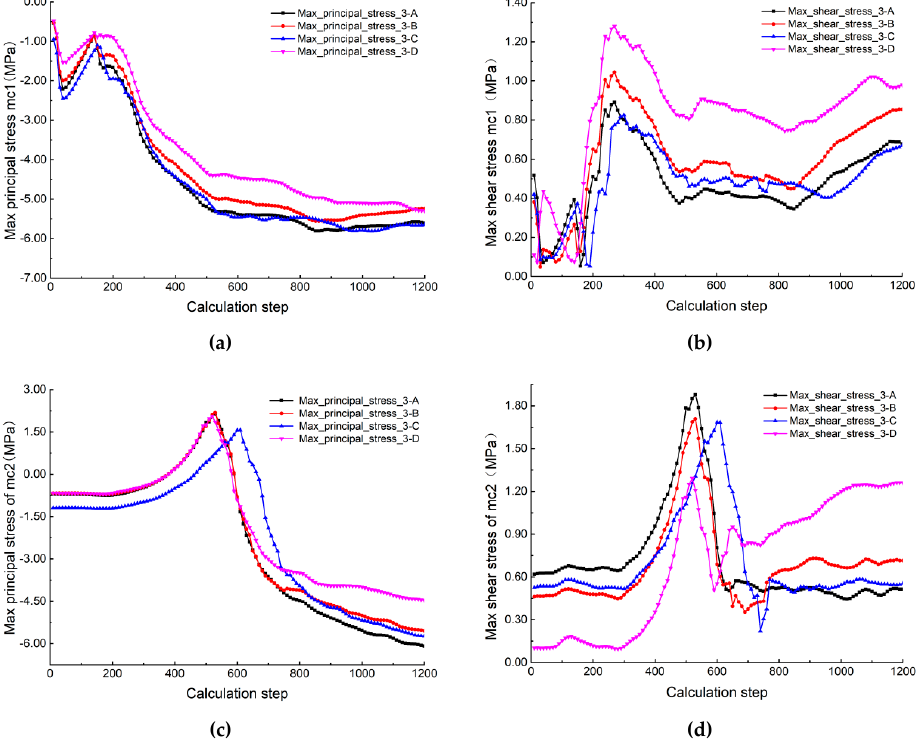
Figure 14. Principal stress curves from 45° and 9.8 MPa under different stresses: ( a ) maximum principal stress history curve of Mc1; ( b ) max shear stress history curve of Mc1; ( c ) max principal stress history curve of Mc2; and ( d ) max shear stress history curve of Mc2.